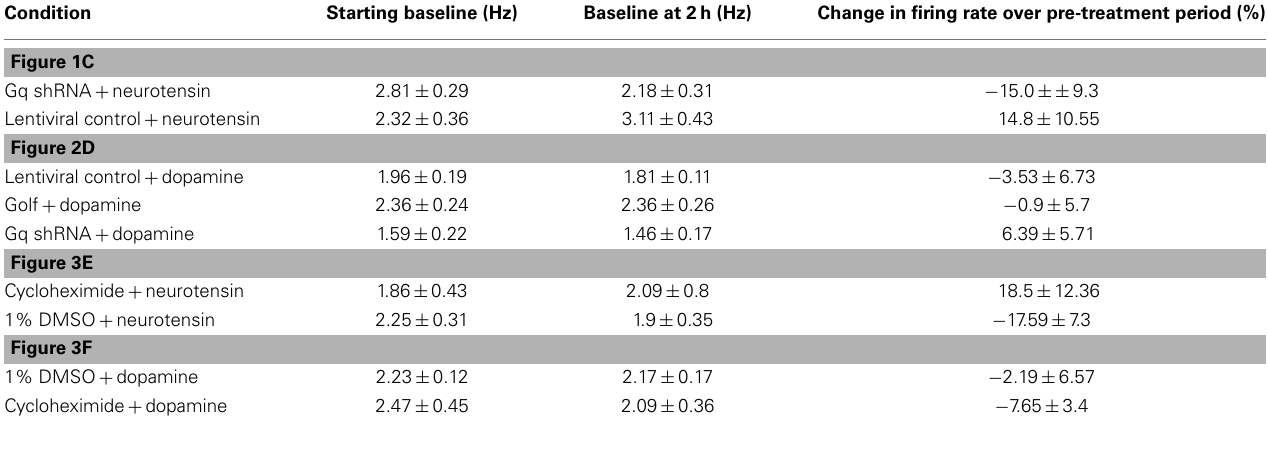
Table 1 | Change in baseline firing rate over 2h of recording with micropipettes containing lentivirus and/or shRNA. Condition Starting baseline (Hz) Baseline at 2h (Hz) Change in firing rate over pre-treatment period (%) Figure 1C Gq shRNA + neurotensin Figure 2D